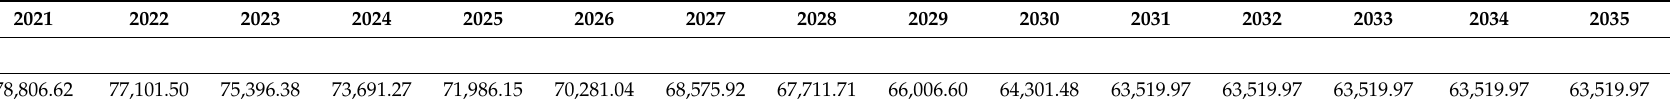
Table 19. Projected values NCF t and indicators FNPV, FRR, FPP [PLN]. Source: designed by